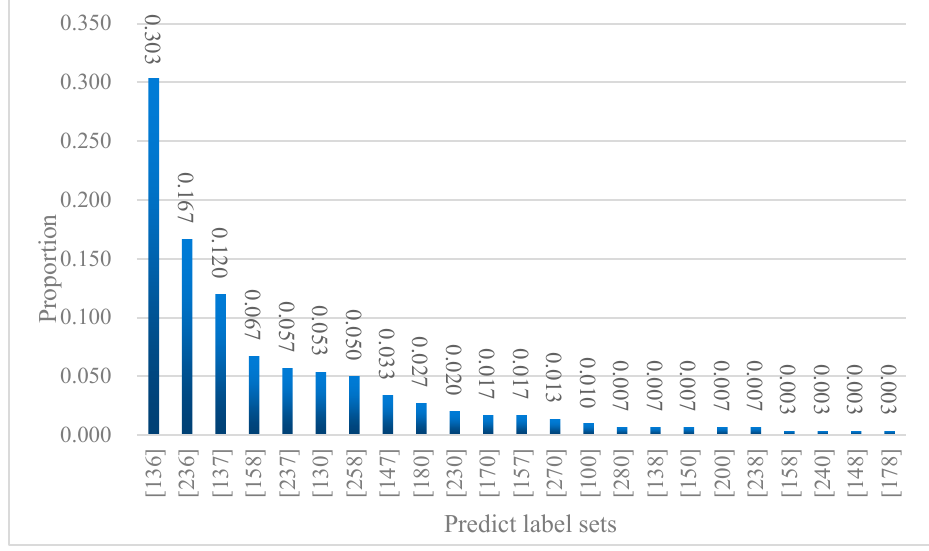
Figure 6. The distribution of user labels.